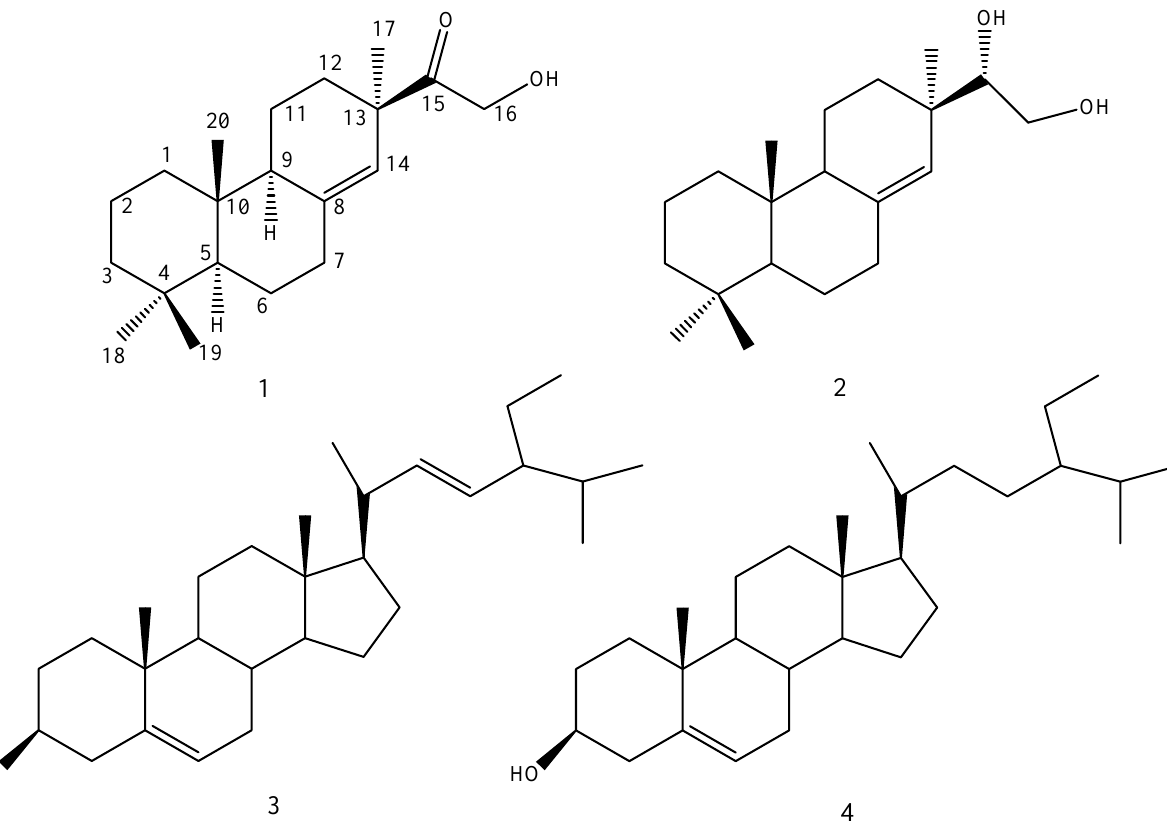
Figure 1. Structure of the